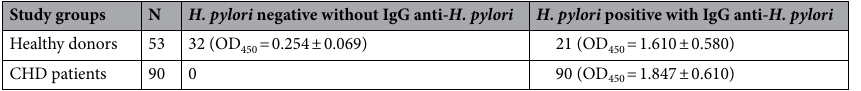
Table 1. The level of IgG anti- H. pylori GE in human serum. Cut off OD 450 = 0.67 ± 0.049; GE glycine extract from the reference H. pylori strain, CHD coronary heart